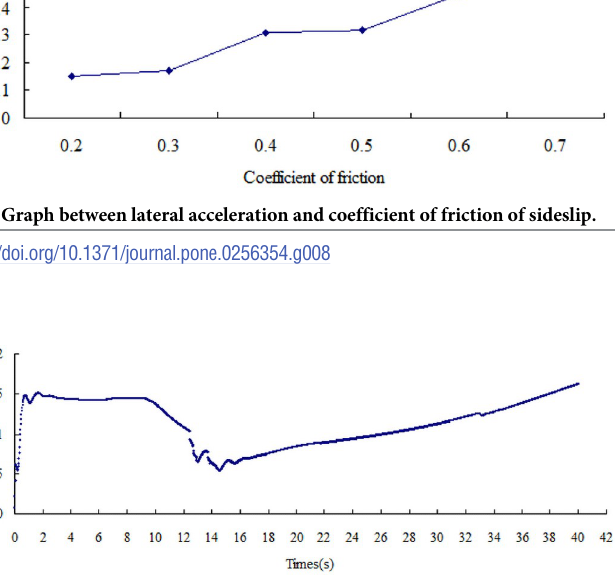
Fig 9. Lateral acceleration change graph of friction coefficient 0.2.